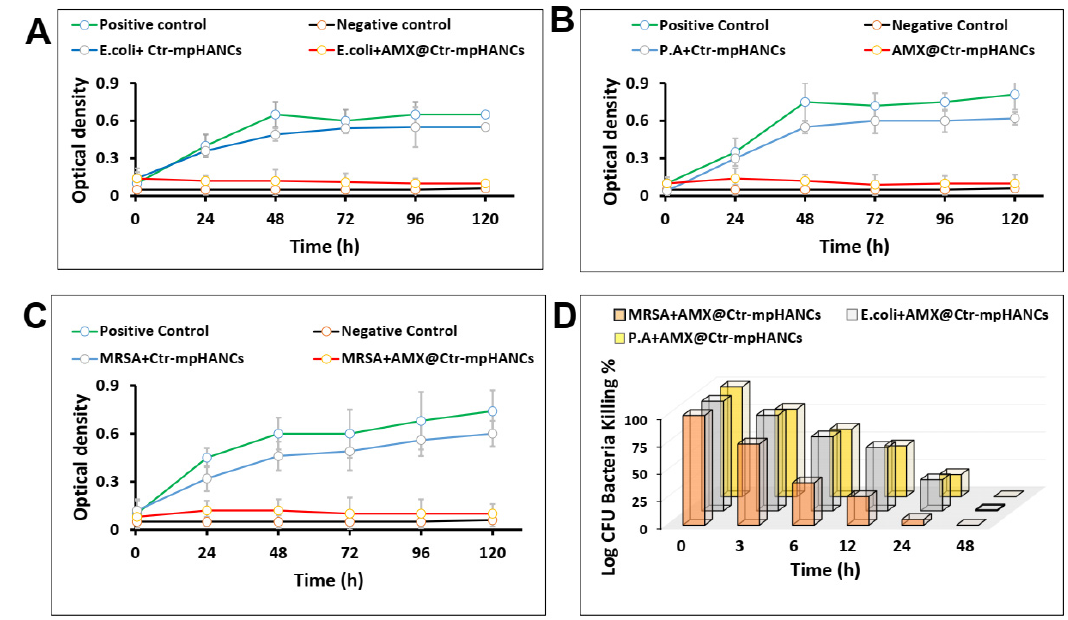
Figure 7. Bacterial kinetics growth of ( A ) E. coli ; ( B ) P. aeruginosa (P.A); ( C ) MRSA in presence of